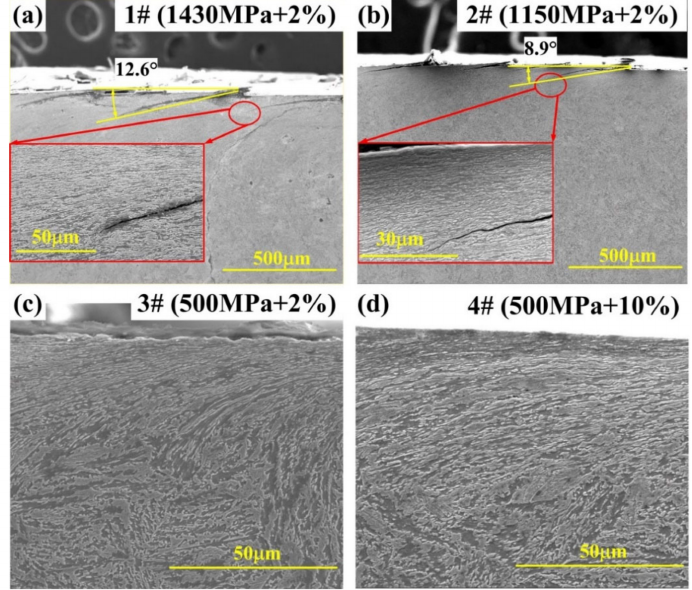
Figure 8. SEM images showing the cross-sectional microstructure of bainitic rail steels ( a ) 1430 MPa +